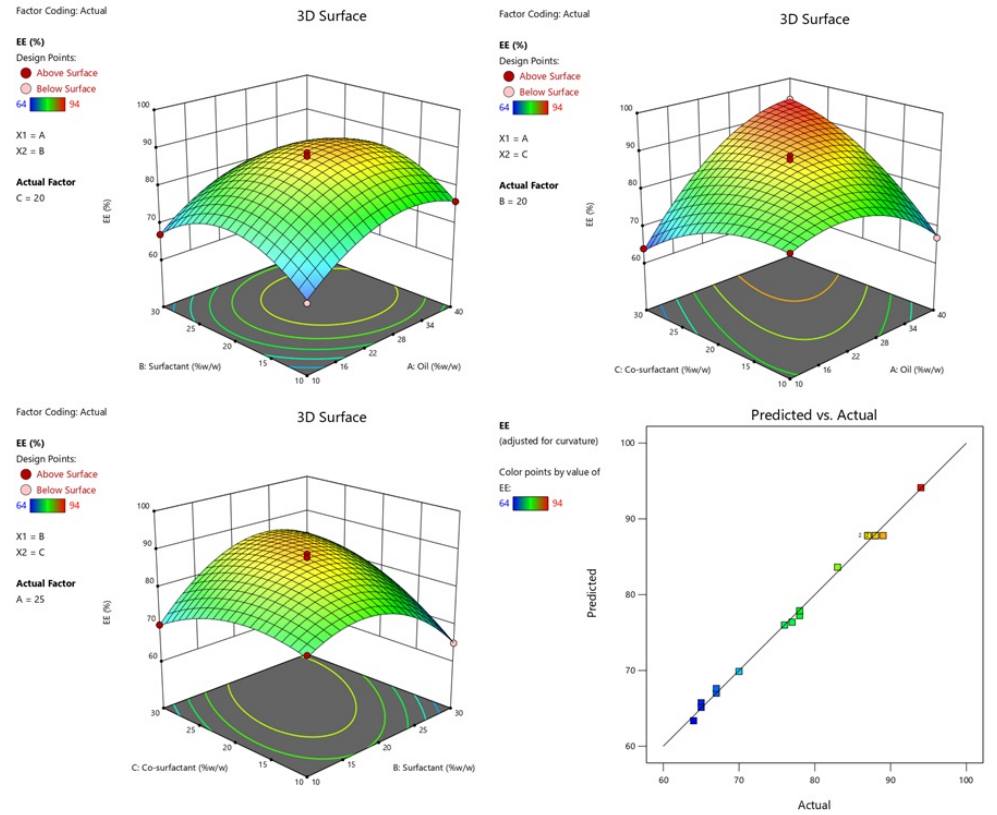
Figure 4. Effect of conc. of oil and surfactant and co-surfactant on %EE, and plot of actual and pre- dicted.